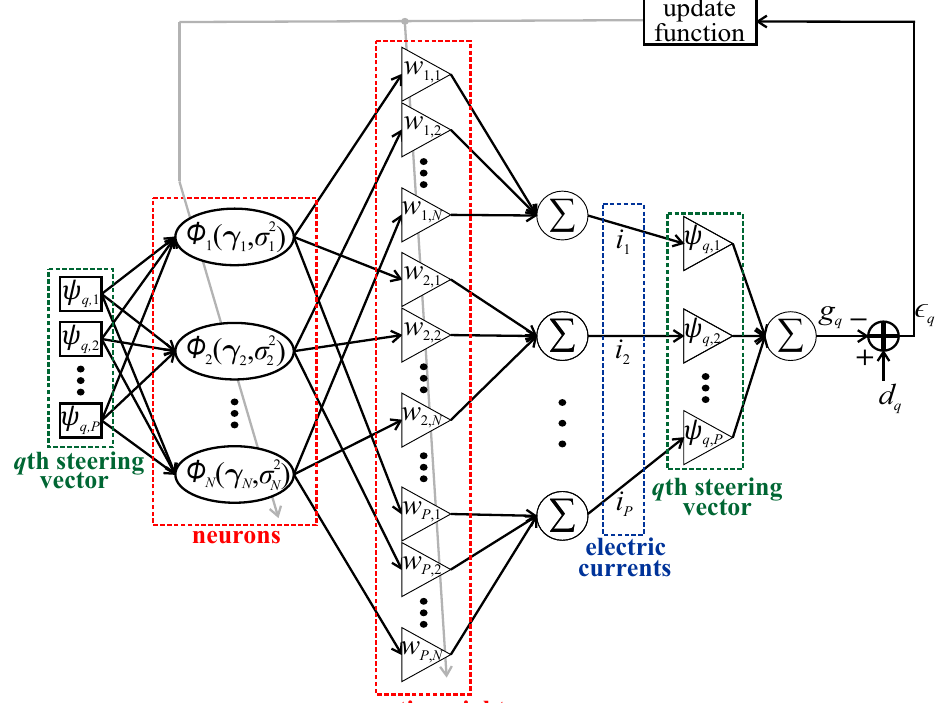
Figure 3. Complex multiple-input multiple-output radial basis function neural network architecture for